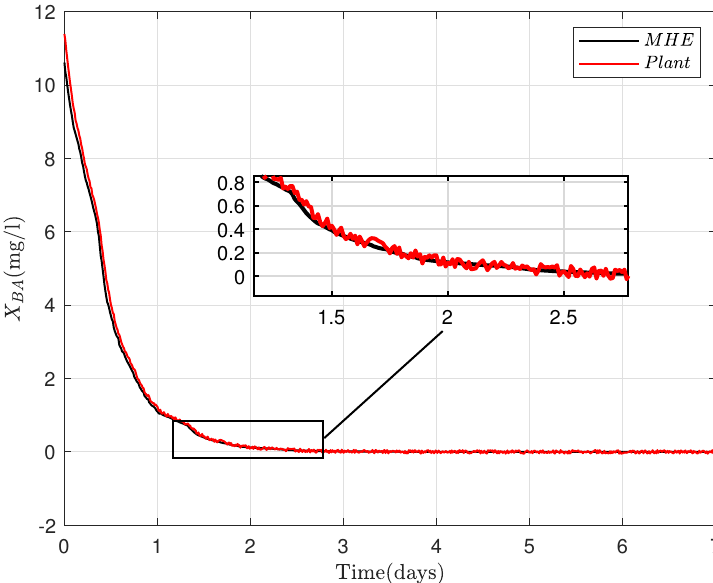
Figure 5. MHE estimate of autotrophic biomass ( X BA ) for 7 days.